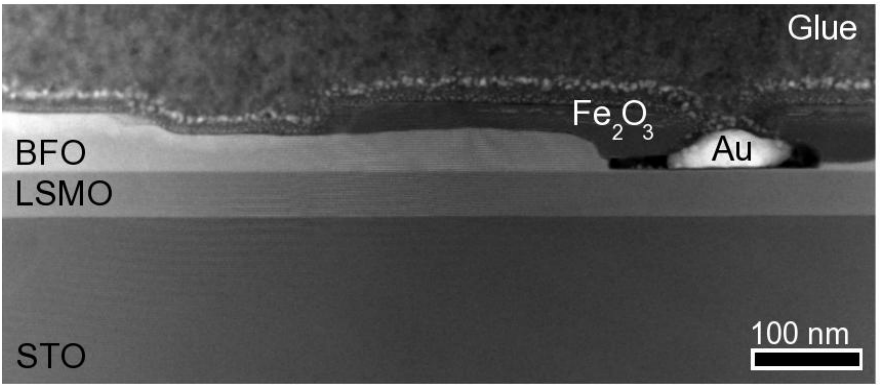
Figure 2. [001] Z-contrast overview